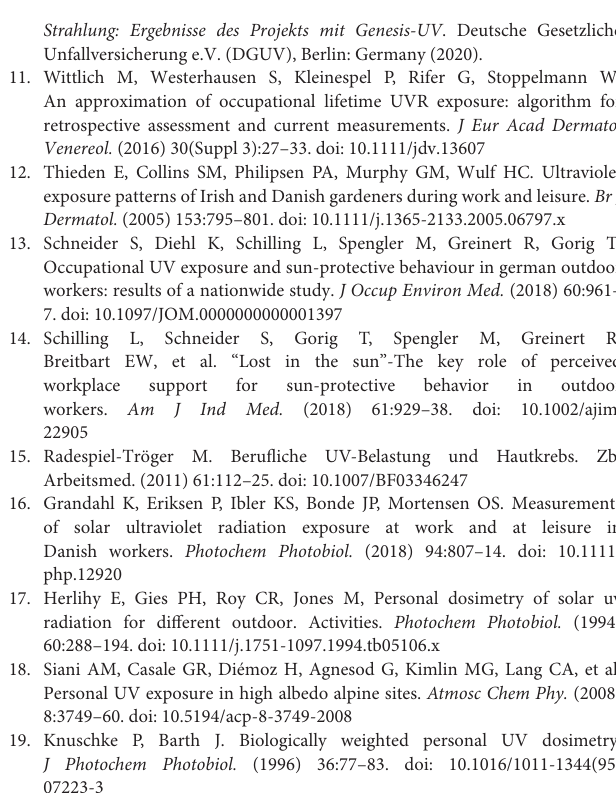
Supplementary Figure 1 | Theoretical values for seasonal and daily dependence of UVR global irradiance. (a) Seasonal factors for the global UV radiation for every month throughout the year (northern hemisphere). The factors for the southern hemisphere are shifted by 6 months. (b) Daytime factors for the global UV radiation throughout a day in temperate climate during summertime. Data taken from (